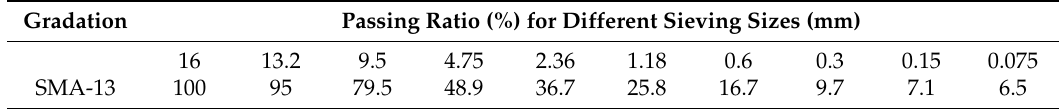
Table 3. Gradation for SMA-13.